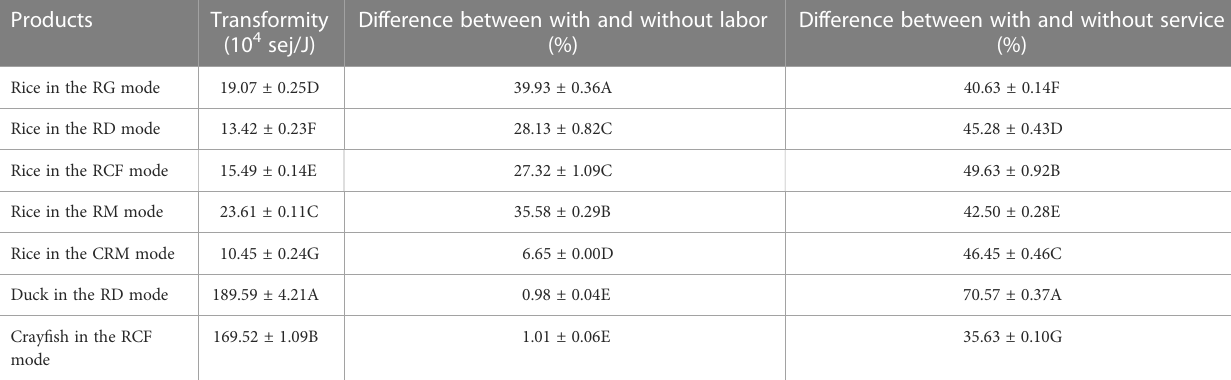
TABLE 4 Transformatives of the products and their differences between with and without labor and between with and without service from the fi ve rice production modes.